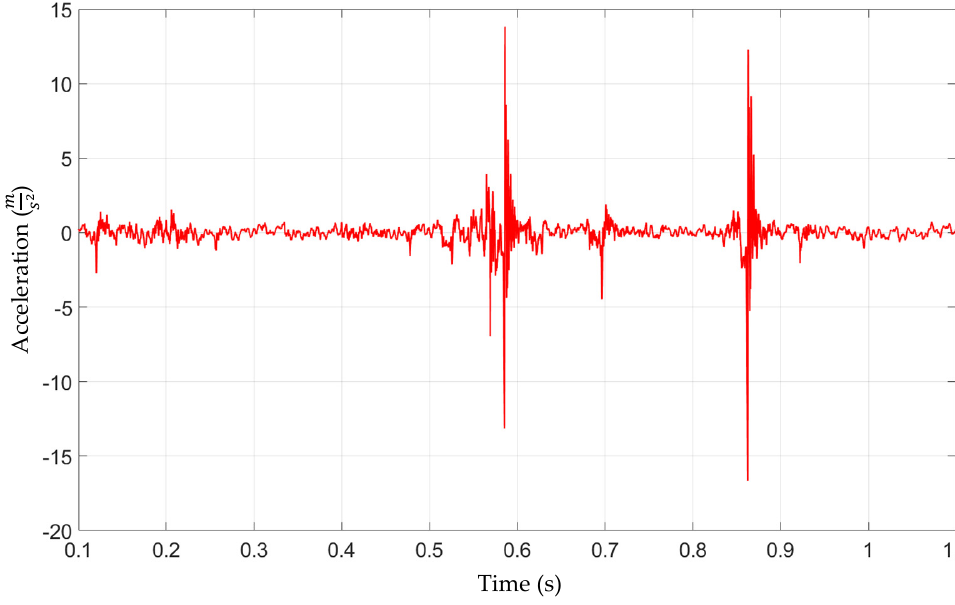
Figure 9. Electric Power Steering (Nominal Production)–Acceleration signal at CRB, 500 N preload.